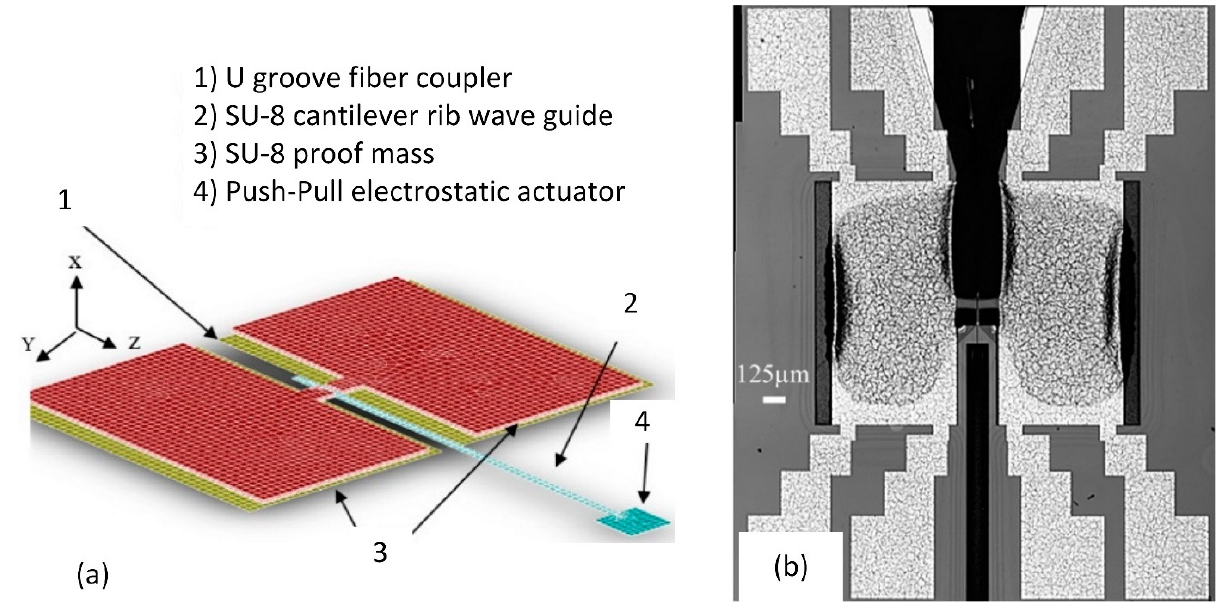
Figure 20. Electrostatic MEMS scanner: ( a ) scheme; ( b ) prototype. Adapted from [117].